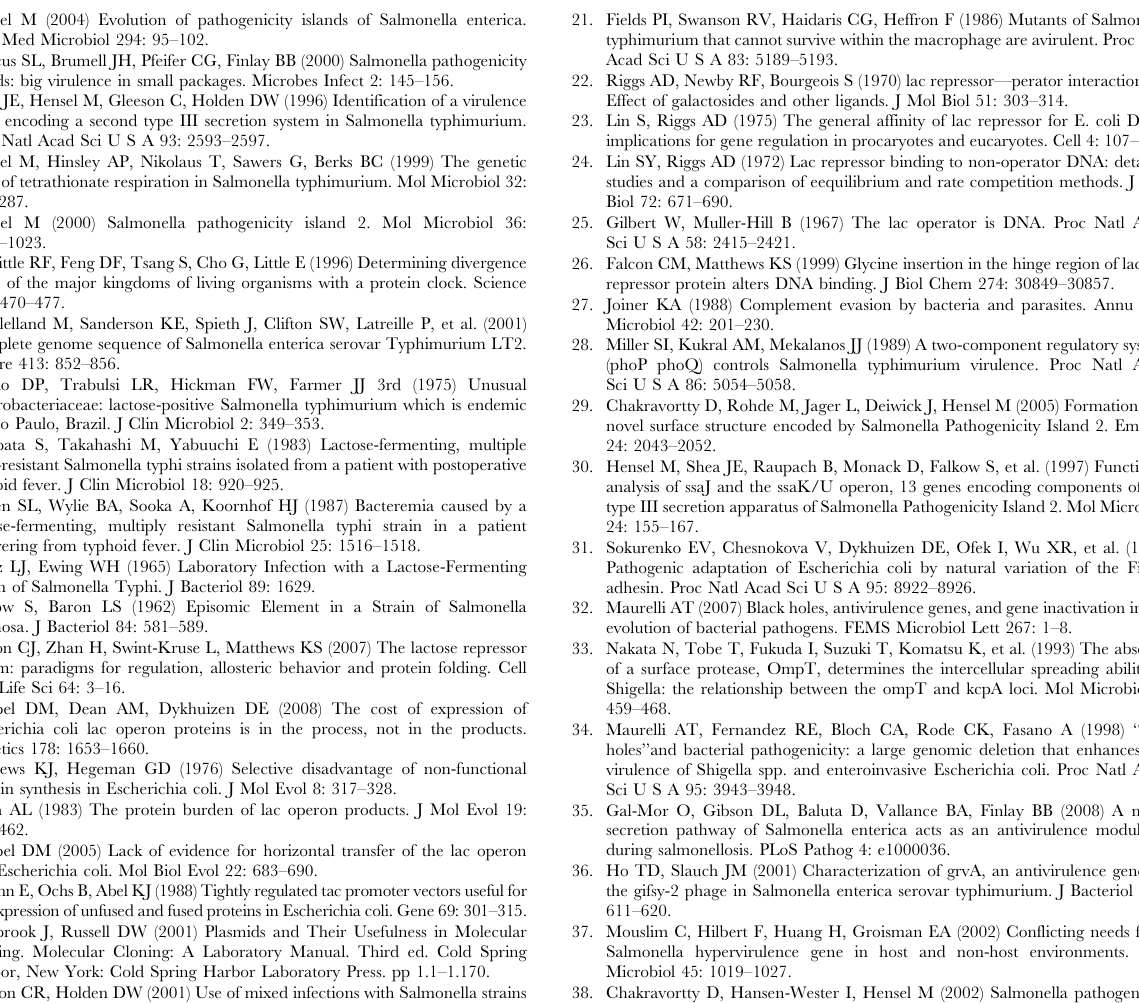
Figure S4 LacI interferes with SPI-2 expression inside macro- phages. The effect of LacI on the expression of virulence genes was analyzed by quantitative real-time PCR. The cDNA was synthesized from the RNA isolated from intracellular bacteria and was used to perform quantitative real-time PCR using DyNAmo TM HS SYBR H Green qPCR Kit. Following conditions were used for all reactions: 40 cycles of 94 u C for 20 sec, 57 u C for 30 sec and 72 u C for 30 sec. Relative amounts of ssaK, sseB and phoP mRNA with respect to rpoD mRNA was quantified. Found at: doi:10.1371/journal.pone.0005789.s009 (8.43 MB